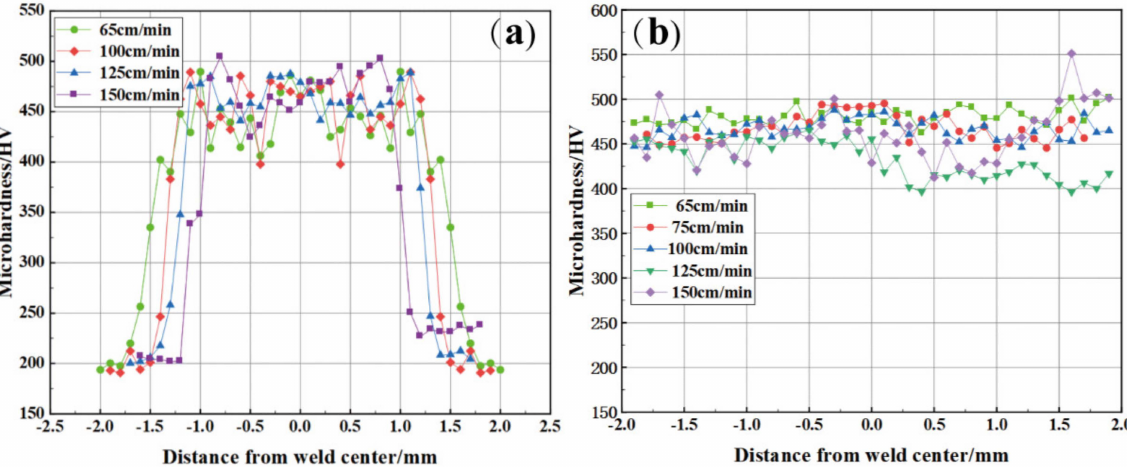
Figure 8. Microhardness of joint at different welding speeds: ( a ) before quenching; ( b ) after quenching.